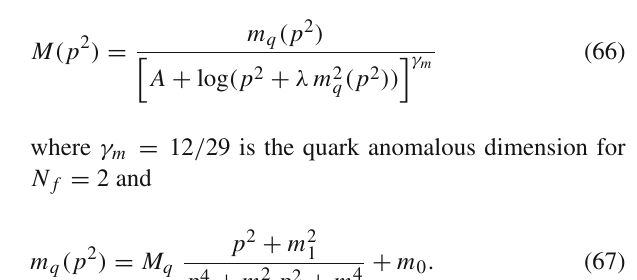
The fitted parameters are M q = 349 ± 10 MeV GeV 2 , m 2